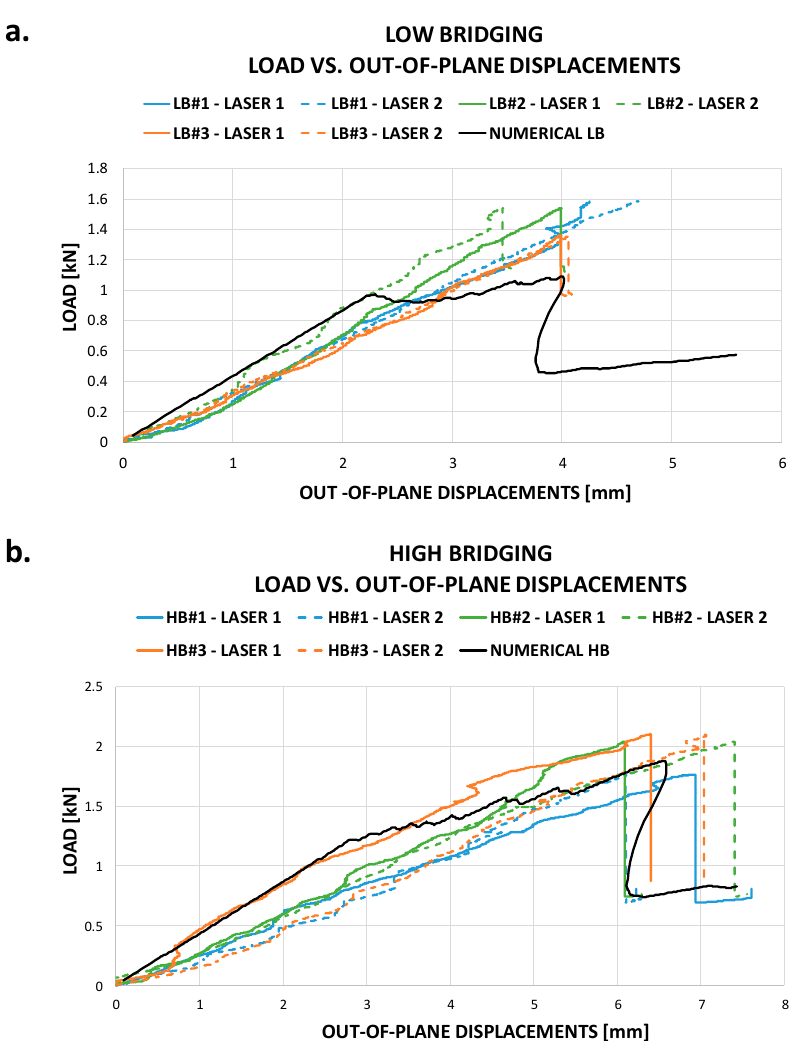
Figure 12. Load vs. Out-of-plane displacements comparison in ( a ) low bridging (LB) sensitivity and ( b ) high bridging (HB) sensitivity.